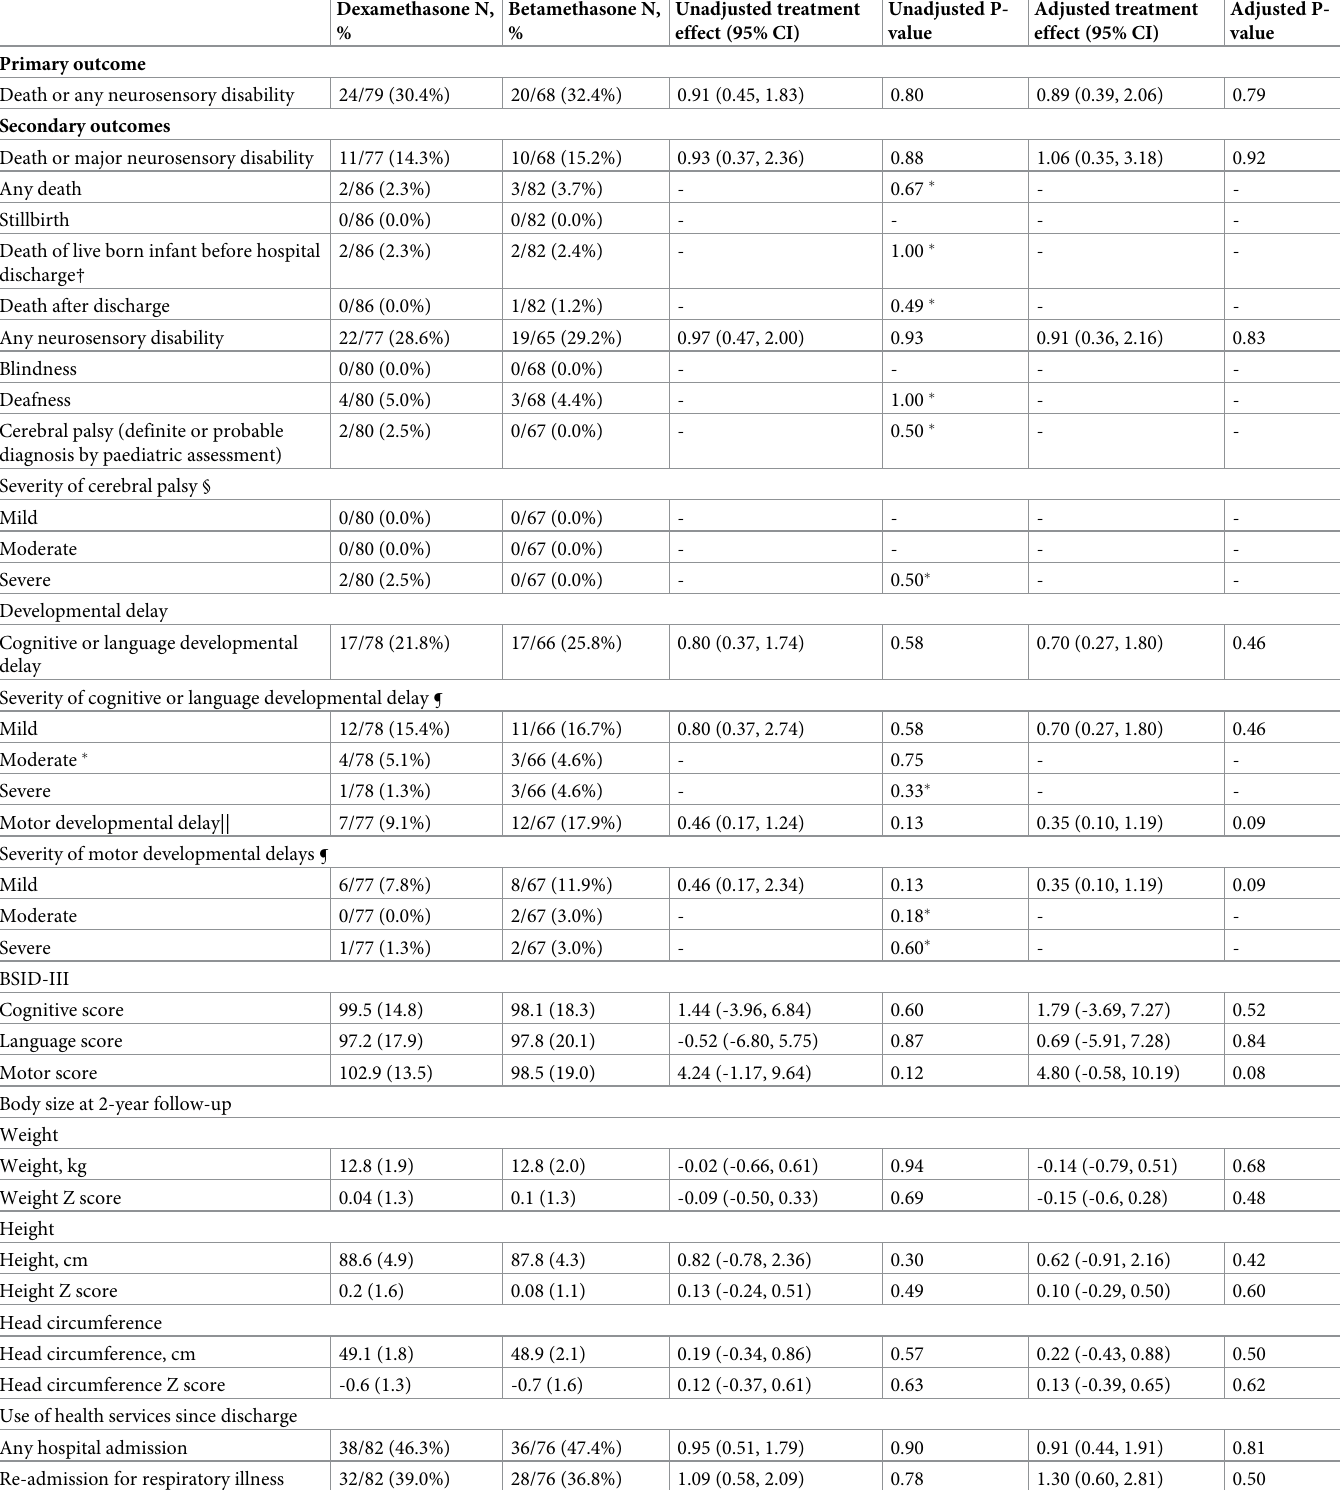
Table 2. Type of antenatal corticosteroid and primary and secondary childhood outcomes at 2